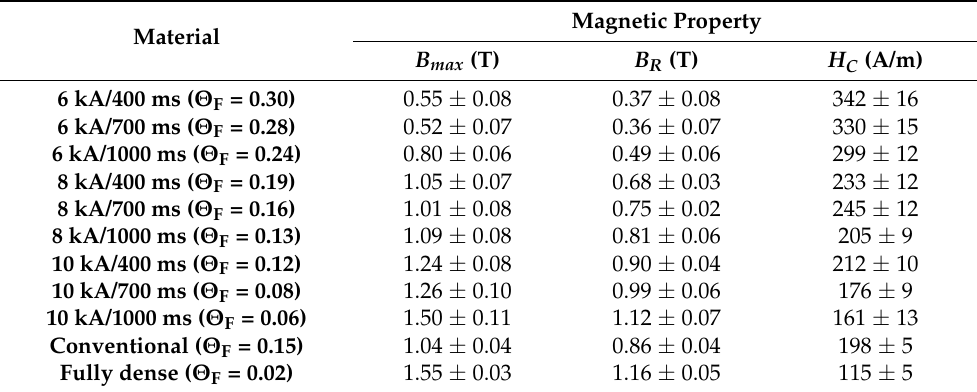
Table 5. Values of the magnetic properties measured for each experiment of ERS, conventionally consolidated compacts and fully dense compacts. The mean values and standard deviations have been computed from the values measured in four compacts obtained under identical